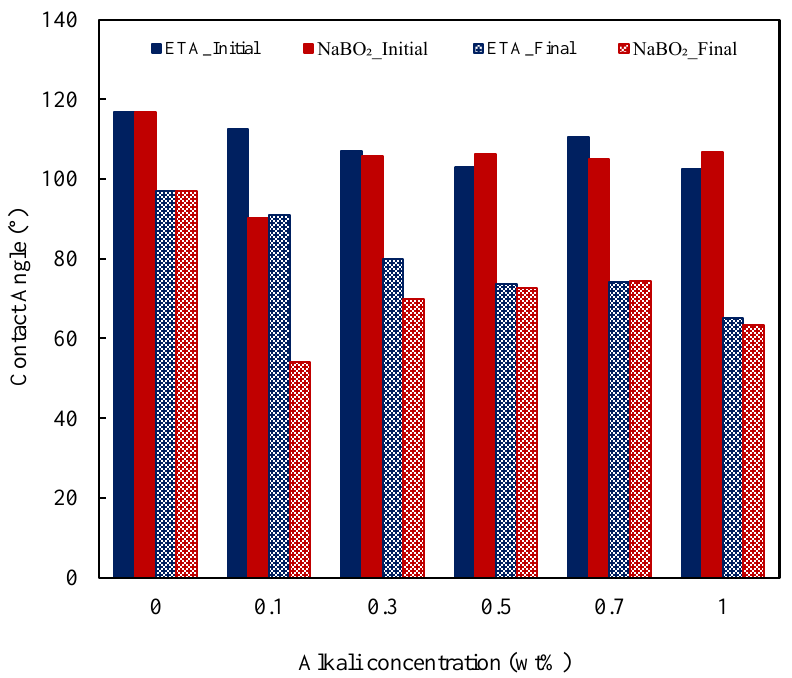
Figure 14. Initial and final contact angle variations with the alkali concentrations for ETA and NaBO 2.